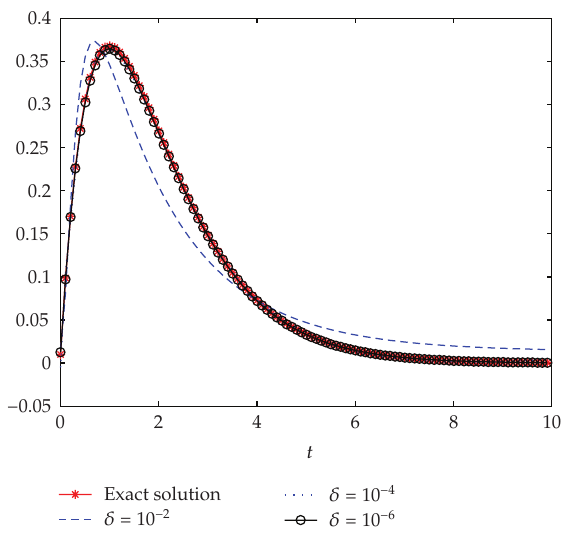
Figure 3: Example 3.3: the stability of the approximate solution.